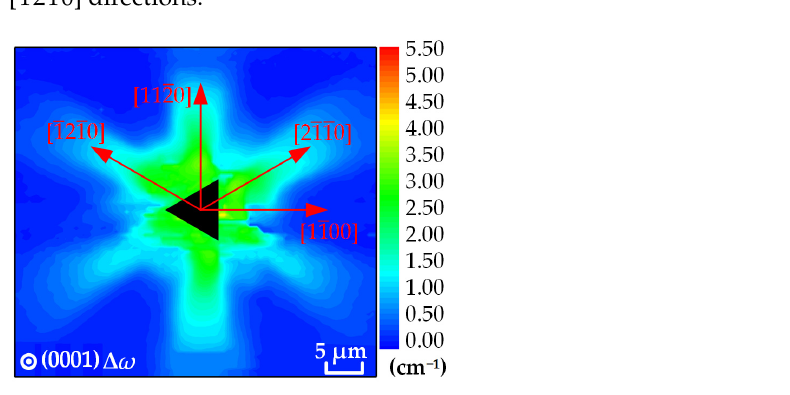
Figure 8. XY mapping of the Raman shift of the E 2high mode around the indentation of the (0001)